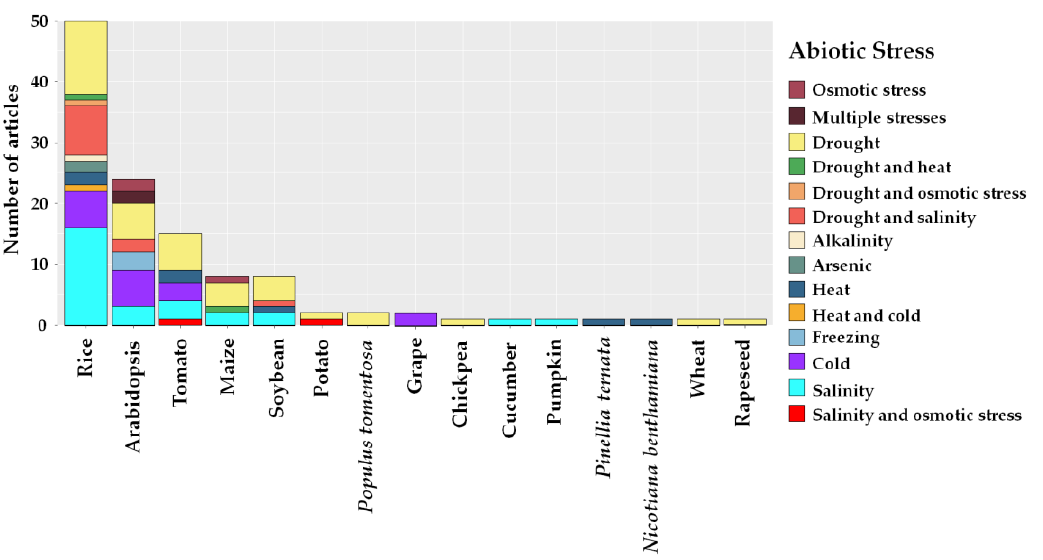
Figure 5. Frequency of crops and abiotic stresses most reported in studies with CRISPR/Cas con- ducted in the last seven years. Article frequency considered that more than one crop and stress was studied per article.